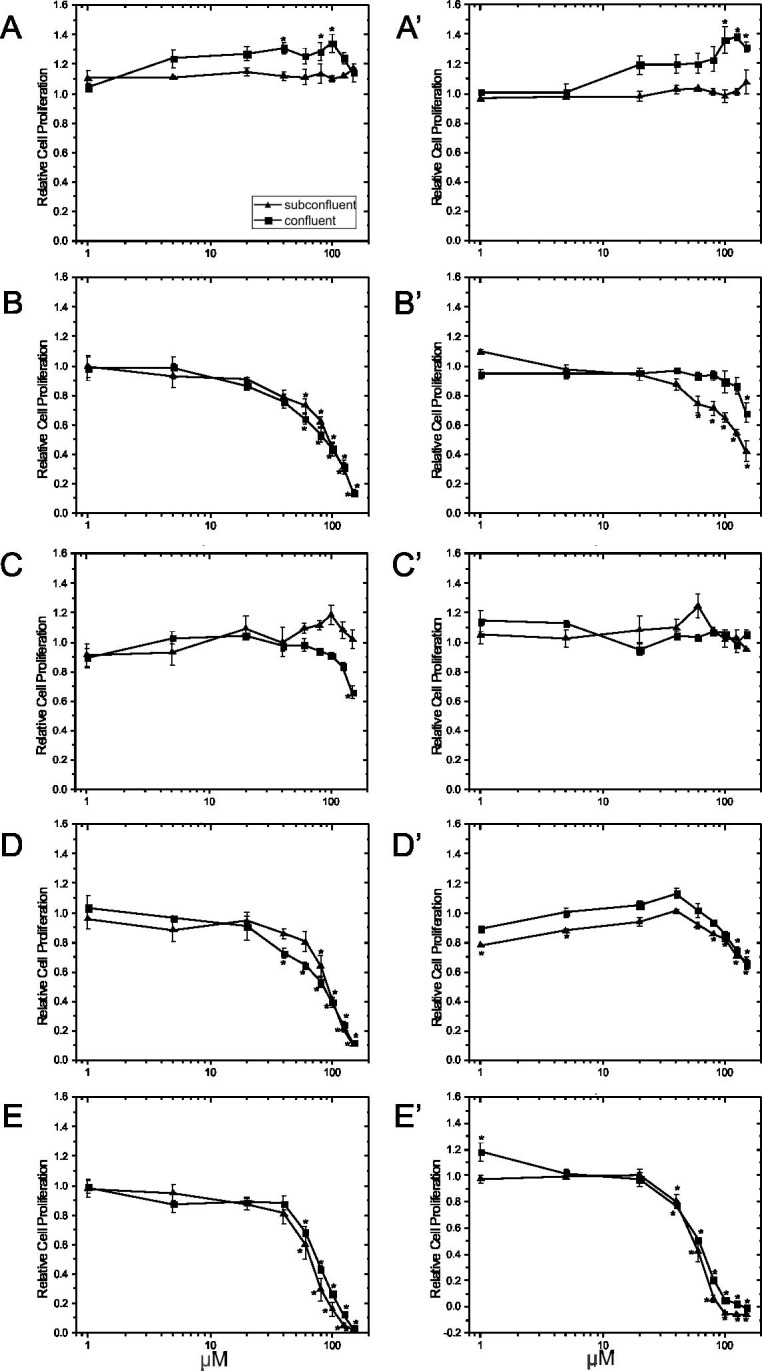
Effect of ECM substrate and growth state on DNA synthesis of EA.hy926 cells in presence of PUFAs.EA.hy926 endothelial cells were seeded on plastic culture plates at 9000 cells/cm2 in the absence (Panel A-E) or presence of Matrigel (Panel A’-E’). Growing cells (day 4) or confluent cells (day 8) were treated with different PUFAs [LA (Panel A, A’), AA (Panel B, B’), ALA (Panel C, C’), EPA (Panel D, D’) and DHA (Panel E, E’)] at final concentrations of 1, 5, 20, 40, 60, 80, 100, 125 and 150 μM for 24 hours, at which point, DNA synthesis was assessed using the BrdU cell proliferation assay. Data are normalized with vehicle control values and plotted as means ± SEM (n = 3). *Significantly different (p <0.05) from the vehicle control for the respective growth state.